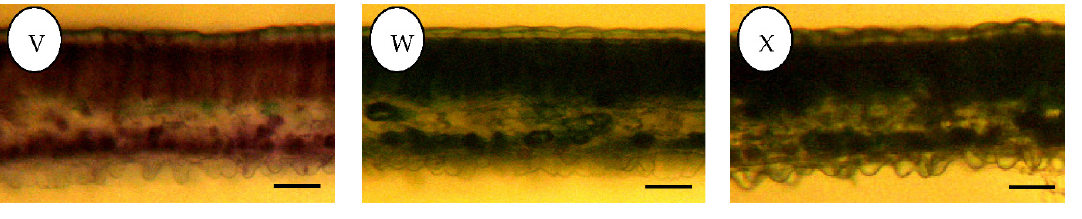
Figure 2. Leaf transversal sections of the Manihot esculenta Crantz, Campinas cultivar, central region of the midrib ( A – C , G – I ) and mesophyll ( D – F , J – L ), and Sergipana cultivar, central region of the midrib ( M – O , S – U ) and mesophyll ( P – R , V – X ). Legend: ADE—adaxial epidermis ( μ m), ABE—abaxial epidermis ( μ m), XY—xylem ( μ m 2 ), PH—phloem ( μ m 2 ), ABC—abaxial collenchyma ( μ m), PP—palisade parenchyma ( μ m), SP—spongy parenchyma ( μ m), CU—cuticle ( μ m), PL—papilla ( μ m); Bars—50 μ m.